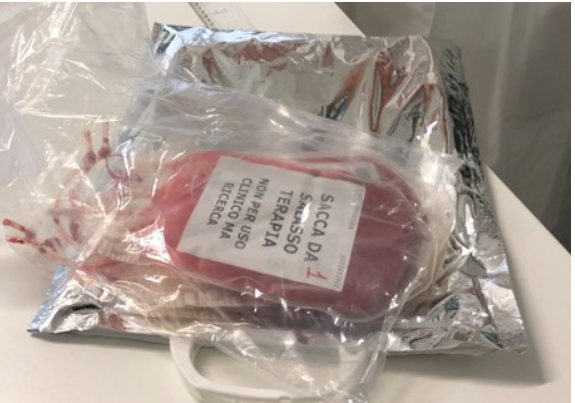
Figure 5. Blood donation bag from bloodletting therapy, which is labeled “bloodletting therapy bag, not for clinical use but for research” in Italian.